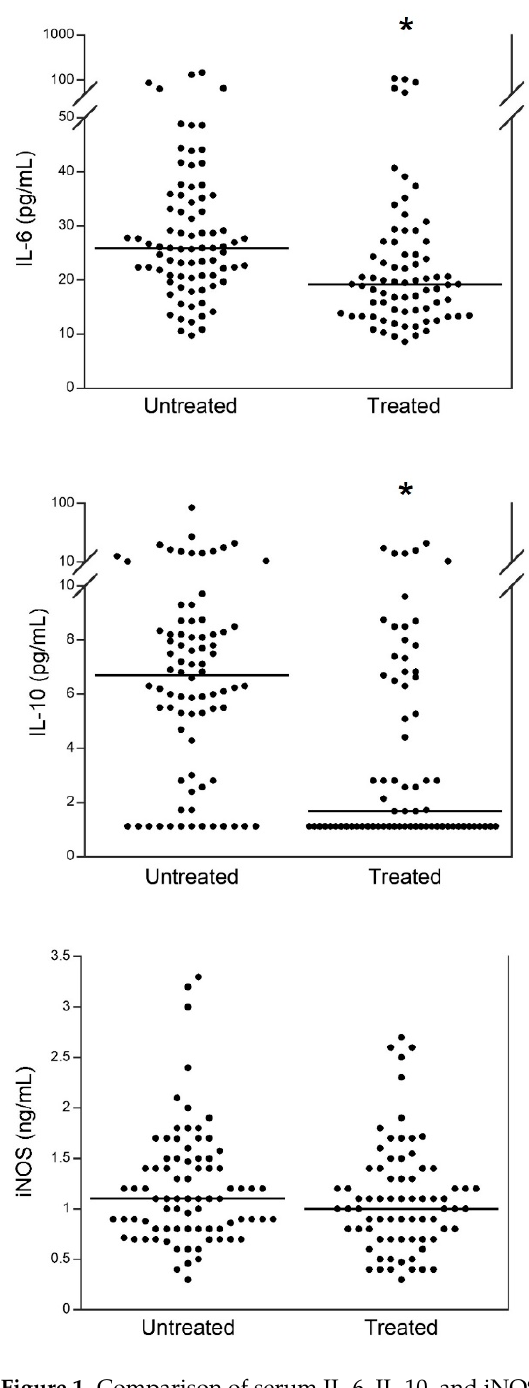
Figure 1. Comparison of serum IL-6, IL-10, and iNOS between 2nd wave patients that have taken steroids and azithromycin before hospital admission and those not treated with either of the two drugs. Black lines correspond to median values. * p < 0.0001.